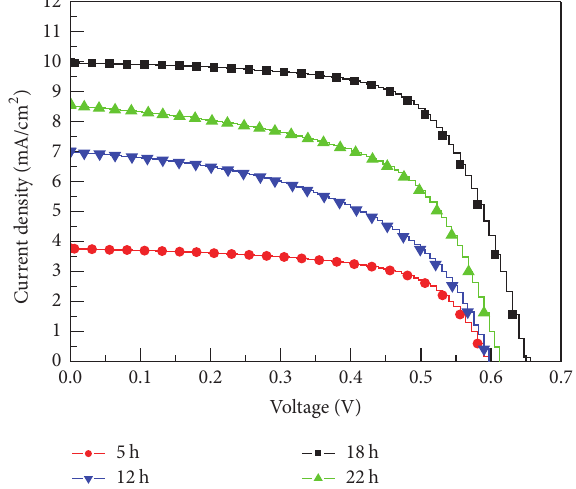
Figure 7: I - V performance of the DSSCs based on P25/TNT arrays double-layer films with different anodization time under AM 1.5